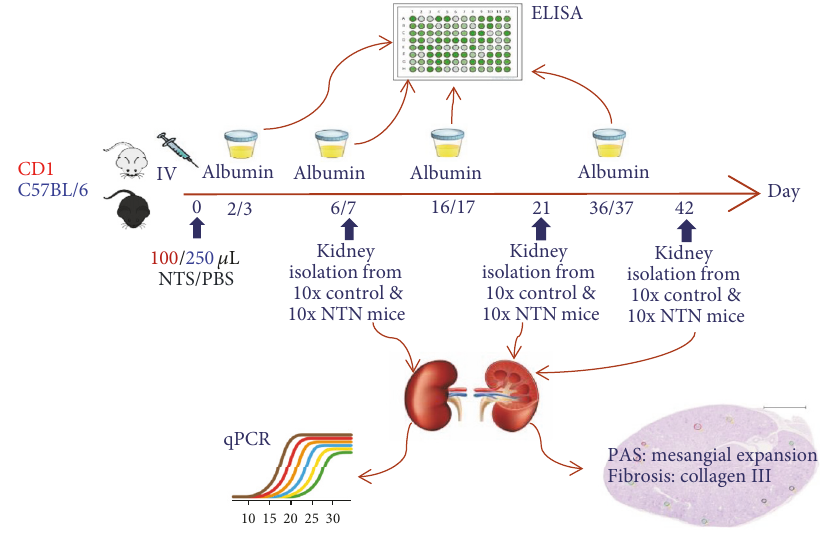
Figure 1: Study set up in C57BL/6 and CD1